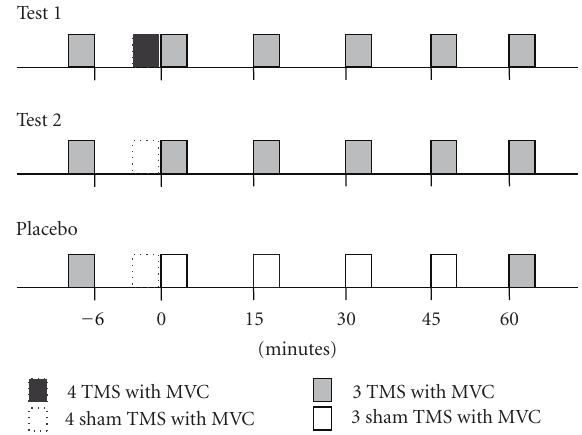
Figure 1: The time schedule of TMS with MVC under the test 1, test 2, or placebo conditions. MEPs were recorded at time points marked as 3 TMSs with